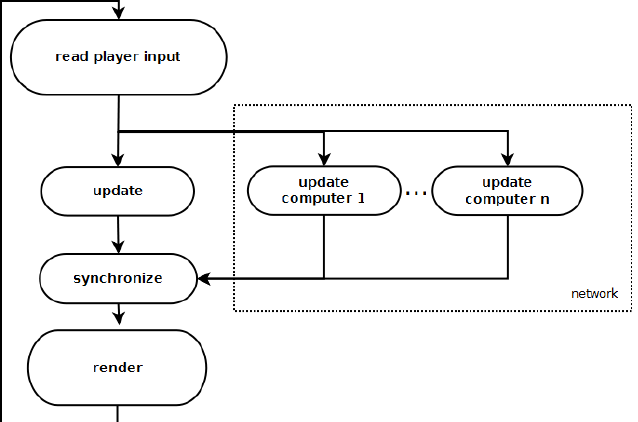
Figure 9. The Cluster